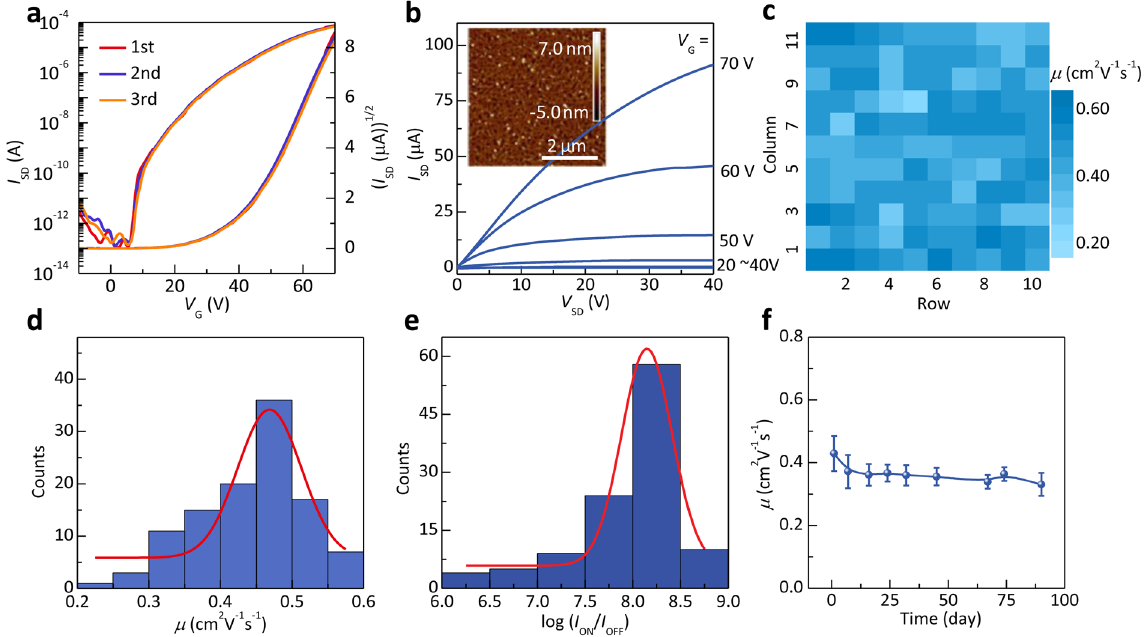
Figure 2. Electrical properties of the PTCDI-C 13 H 27 thin-film transistor: ( a , b ) Typical transfer and output curves of the device. ( a ) Shows the multi-measured results. The inset is AFM image of 5-nm-thick PTCDI-C13 thin films. ( c ) Field-effect mobility mapping of the 10 × 11 phototransistor array. ( d , e ) Electron mobility and log( I on / I off ) distribution of 110 transistors. ( f ) Electron mobility change with time for 90 days in ambient condition from 10